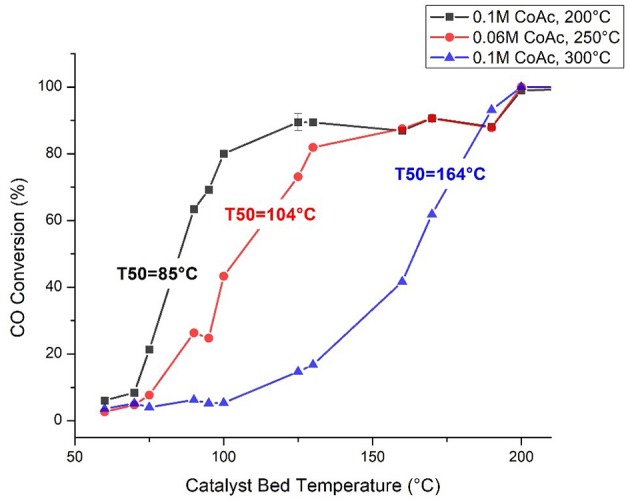
CO oxidation light-off curves for selected catalysts.